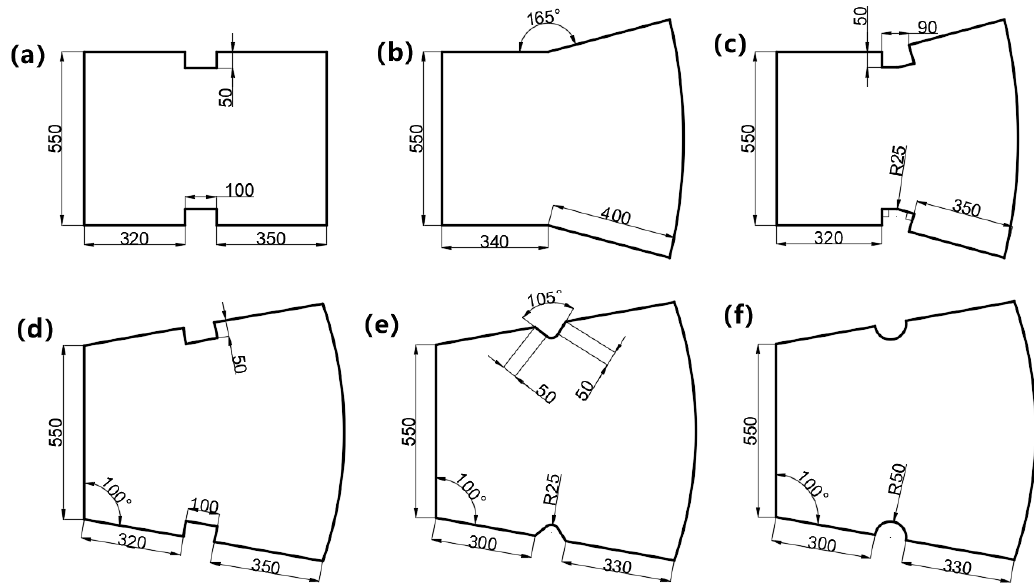
Figure 6. Schematic diagram of various initial blank geometry: ( a ) Blank A; ( b ) Blank B; ( c ) Blank C; ( d ) Blank D; ( e ) Blank E; ( f ) Blank F.